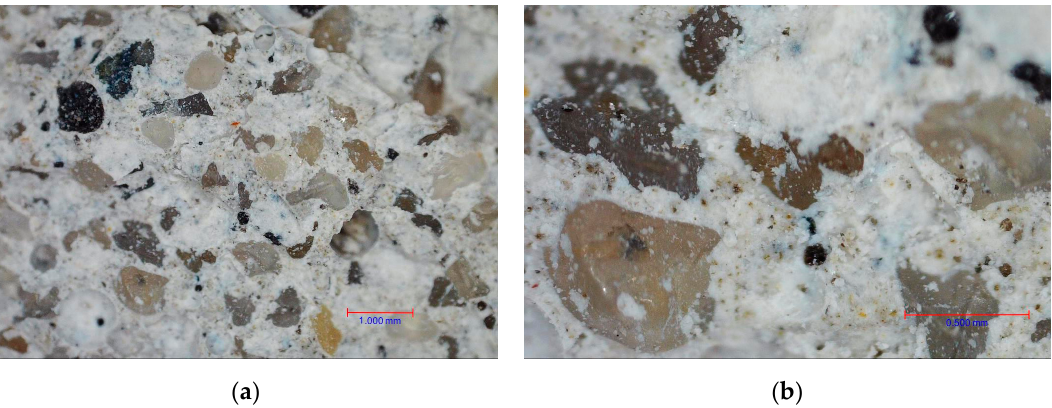
Figure 2. Macrostructure of ternary system mortar ( a ) under magnification of 40x, ( b ) under magnification of 120x.